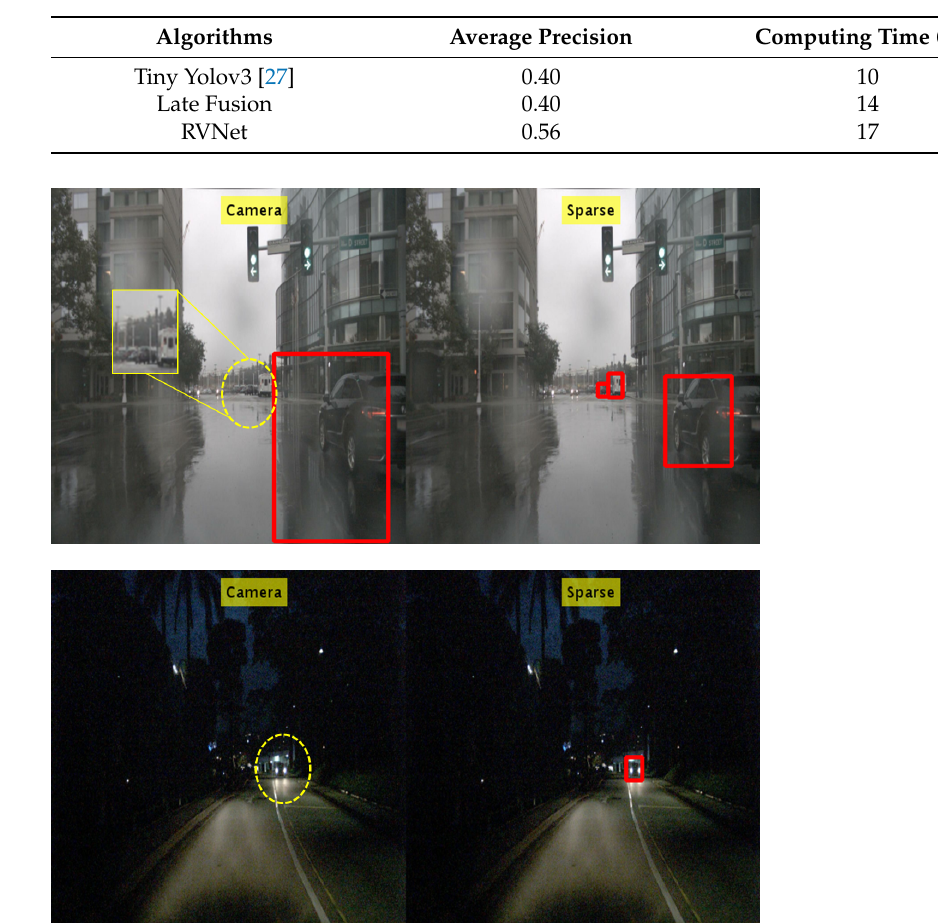
Table 3. Comparative Analysis of the RVNet.